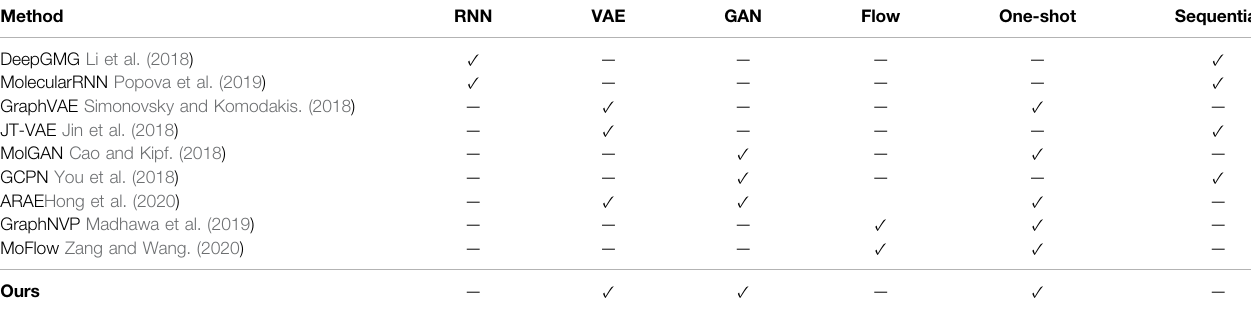
TABLE 1 | Mainstream methods of molecular